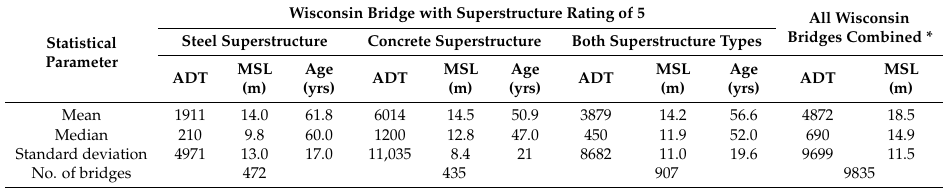
Table 3. Statistical information on the Wisconsin NBI data used in the analyses. Statistical